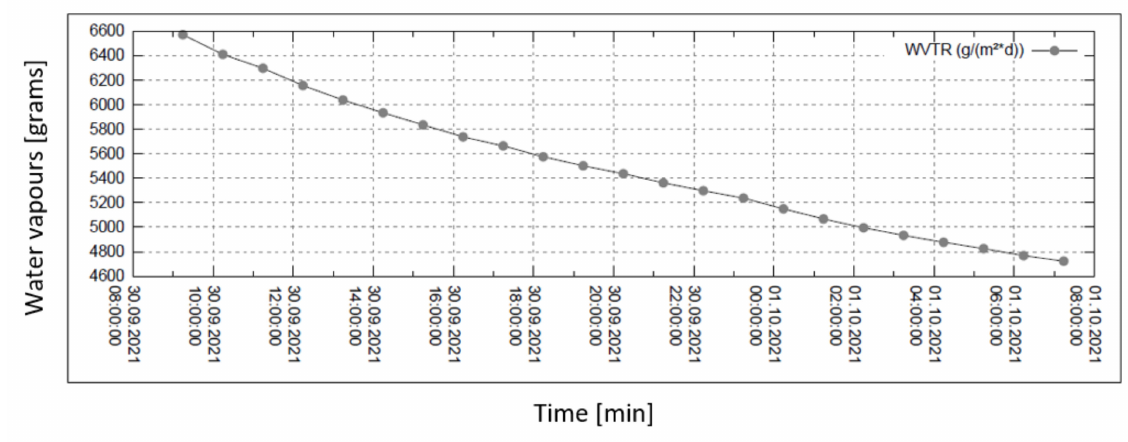
Figure 7. Permeability of water vapour over 24 h with 30% external humidity.